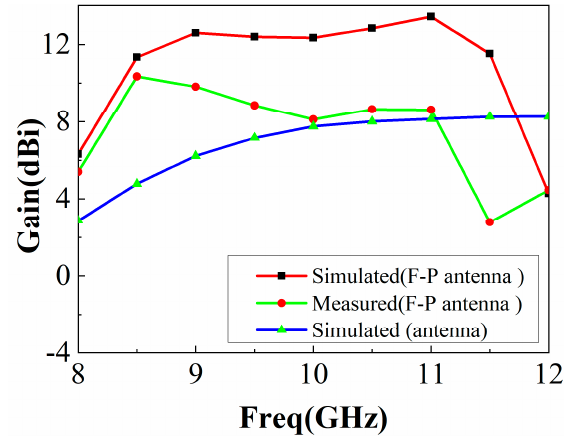
Figure 20. Prototype antenna’s gain measurement and simulation.